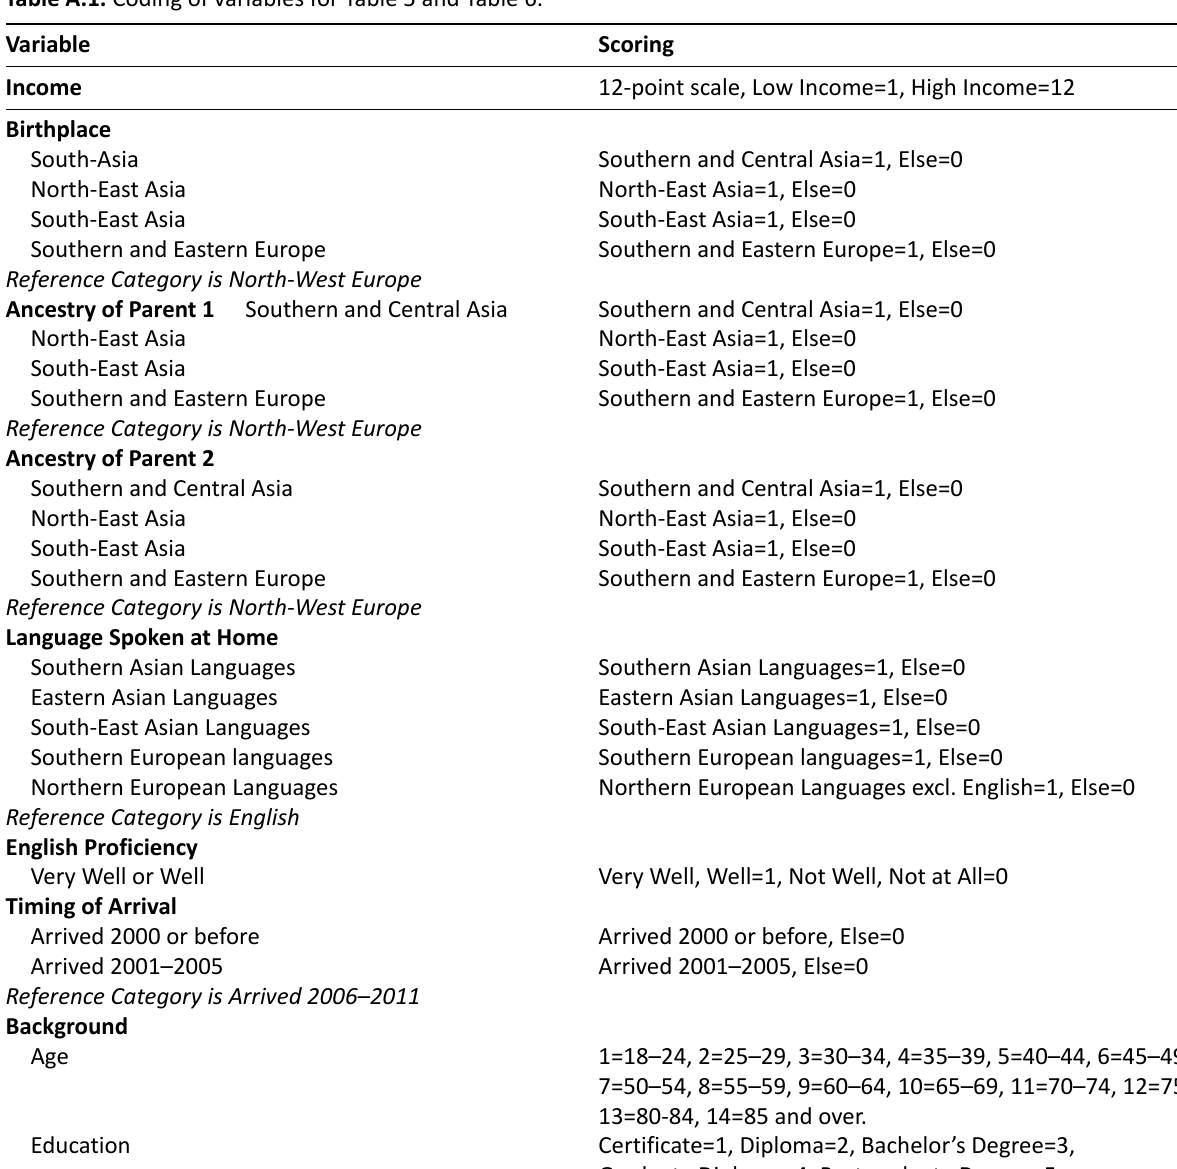
Table A.1. Coding of variables for Table 5 and Table